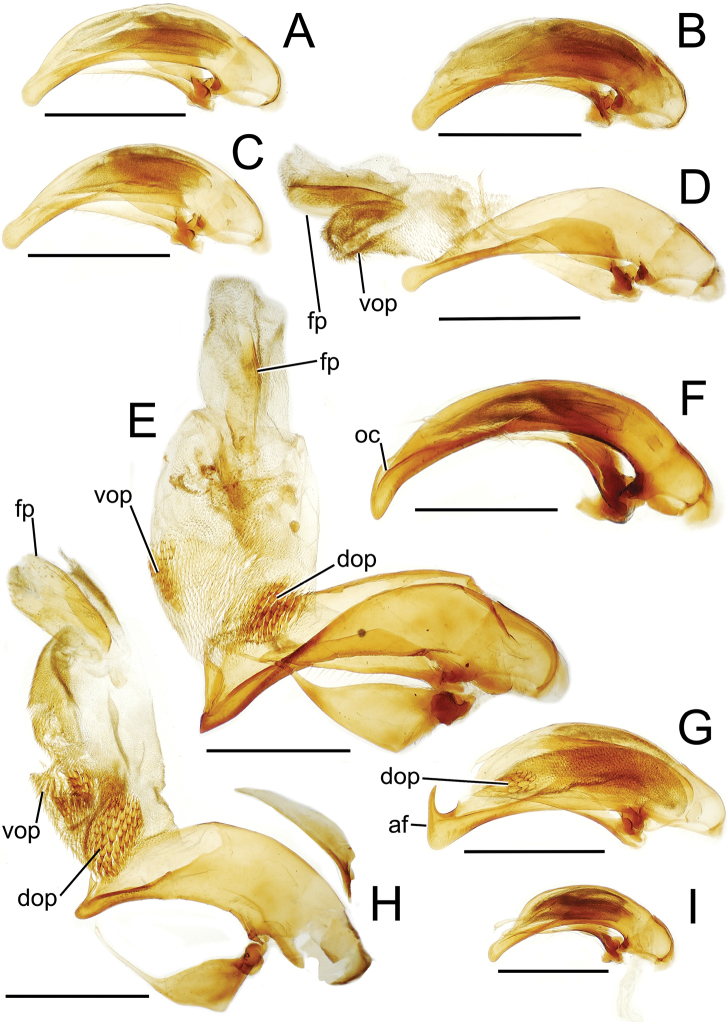
Male aedeagal median lobe and associated parameres, Mecyclothorax spp., right lateral view; scale bars 0.5 mm A
Mecyclothorax globosus, Marau B
Mecyclothorax globosus, Marau C
Mecyclothorax globosus, Aorai D
Mecyclothorax paraglobosus, internal sac everted E
Mecyclothorax cupreus, internal sac everted F
Mecyclothorax pirihao paratype (CUIC) G
Mecyclothorax spinosus paratype (MHNB) H
Mecyclothorax cupreoides paratype (MHNB), interal sac everted I
Mecyclothorax laevilateralis Abbreviations: af apical face dop dorsal ostial microtrichial patch fp flagellar plate oc ostial canal vop ventral ostial microtrichial patch.